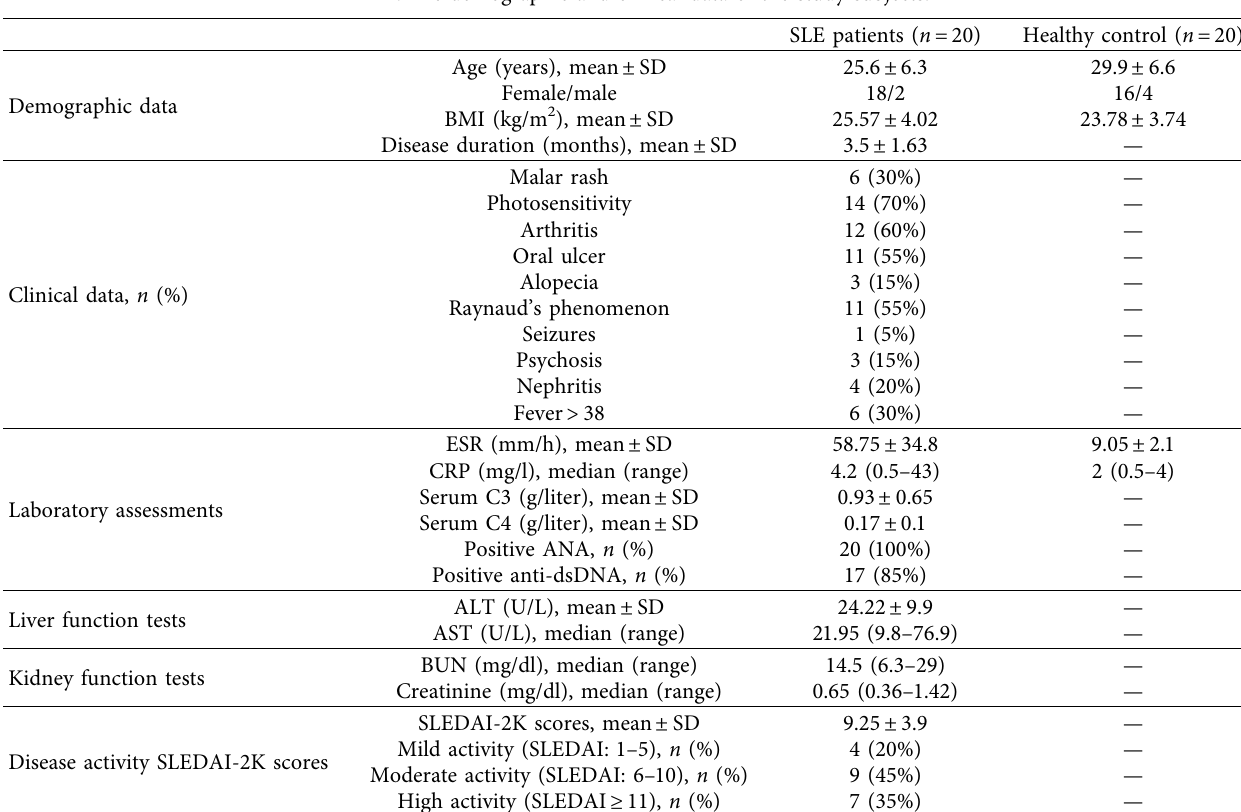
Table 2: The demographic and clinical data of the study subjects.